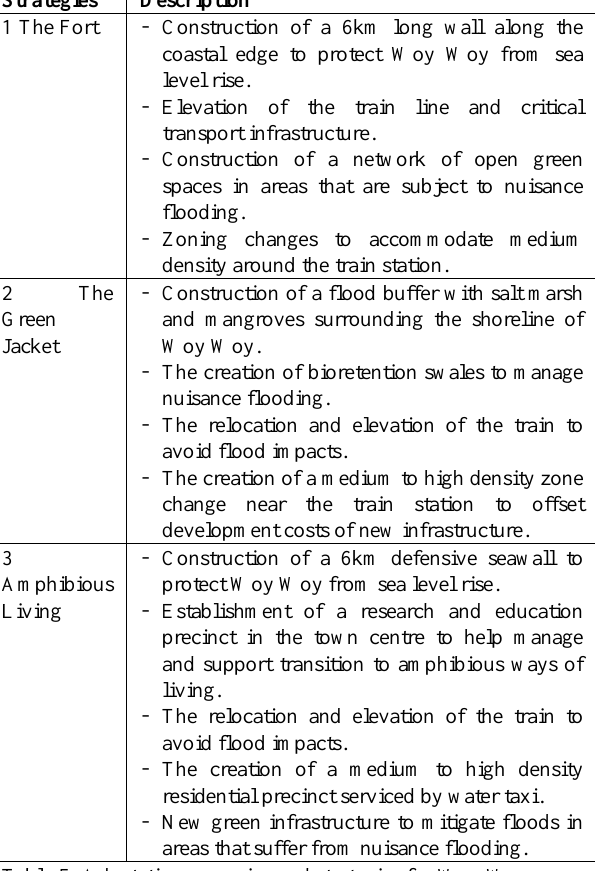
Table 5: Adaptation scenarios and strategies for Woy